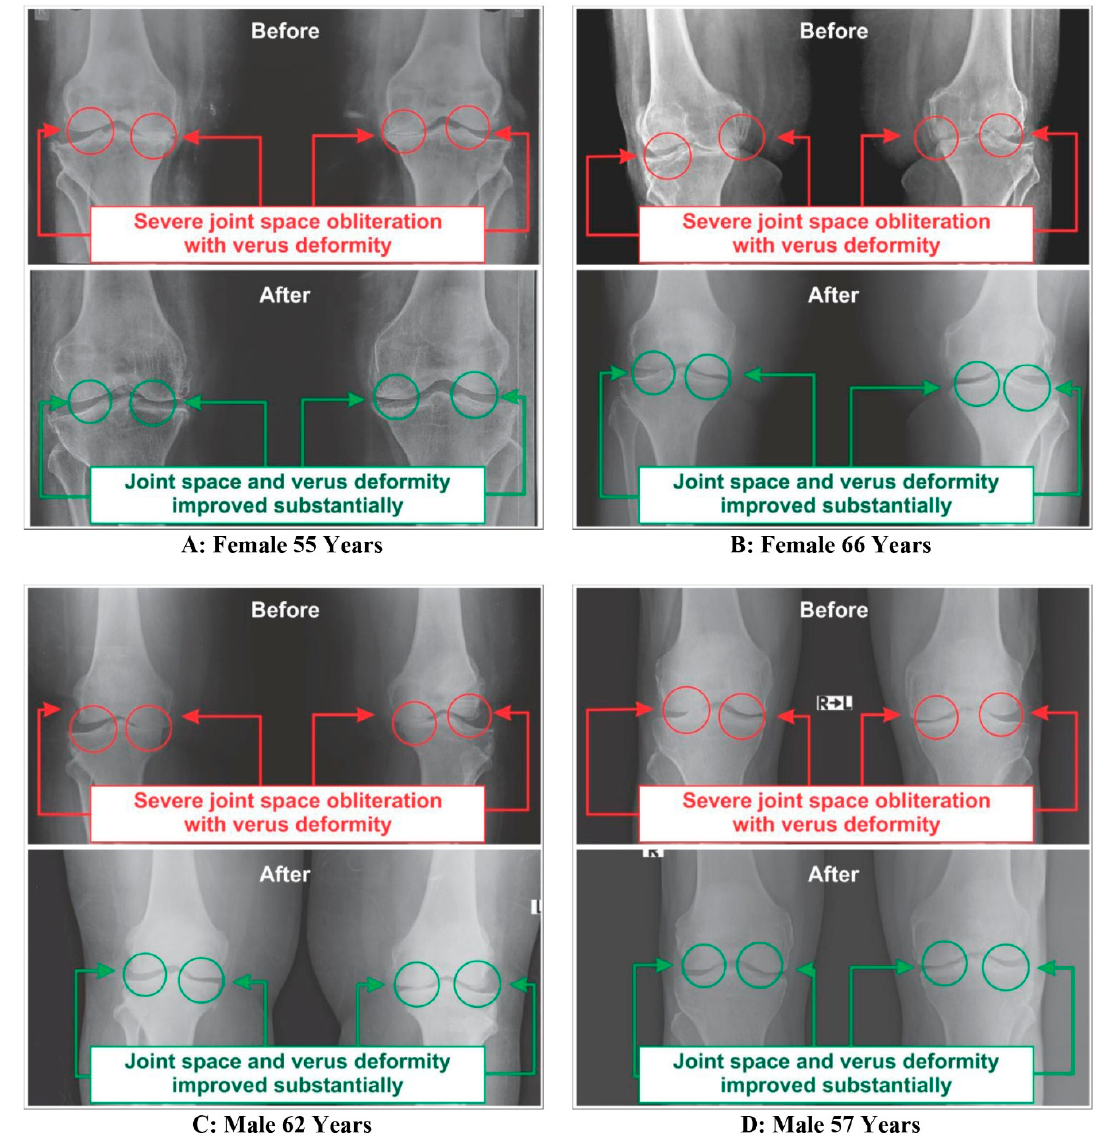
Figure 11. Radiological images of knee joints (two-female and two-male) showing before and after the treatment with supplement.